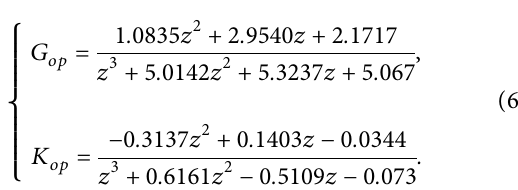
Figure 1: Switching control